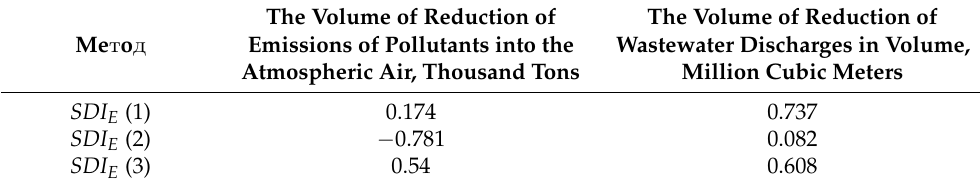
Table 2. Correlation coefficients between SDI E and environmental indicators (according the author’s